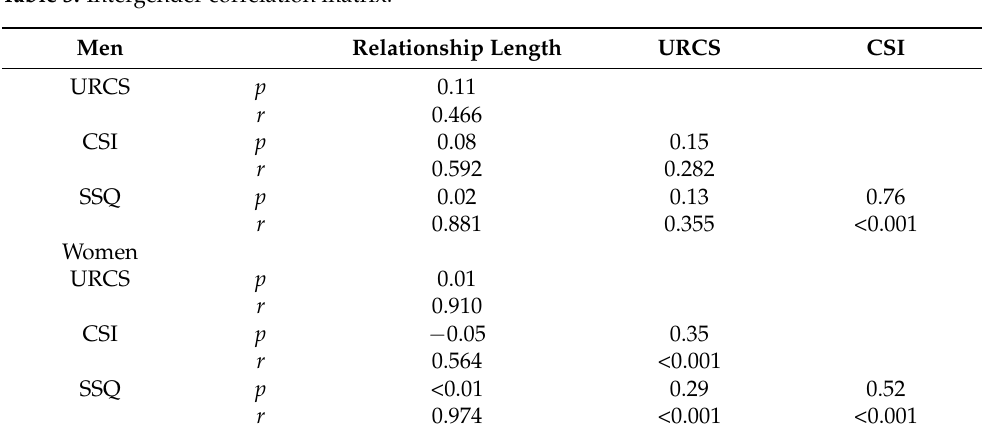
Table 3. Intergender correlation